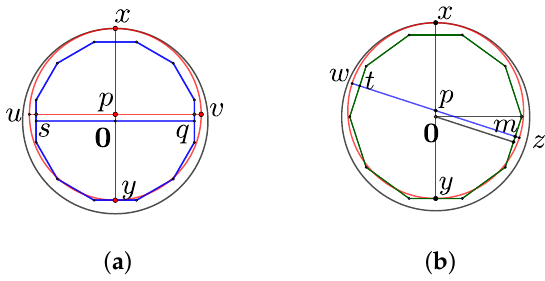
Figure 1. n is even. ( a ) n ≡ 0 ( mod4 ) ; ( b ) n ≡ 2 ( mod4 ) .